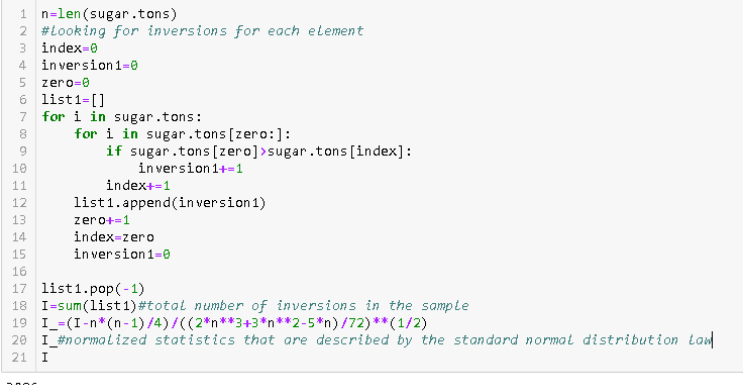
Figure 3. Implementation of the statistical test of inversions in Python.